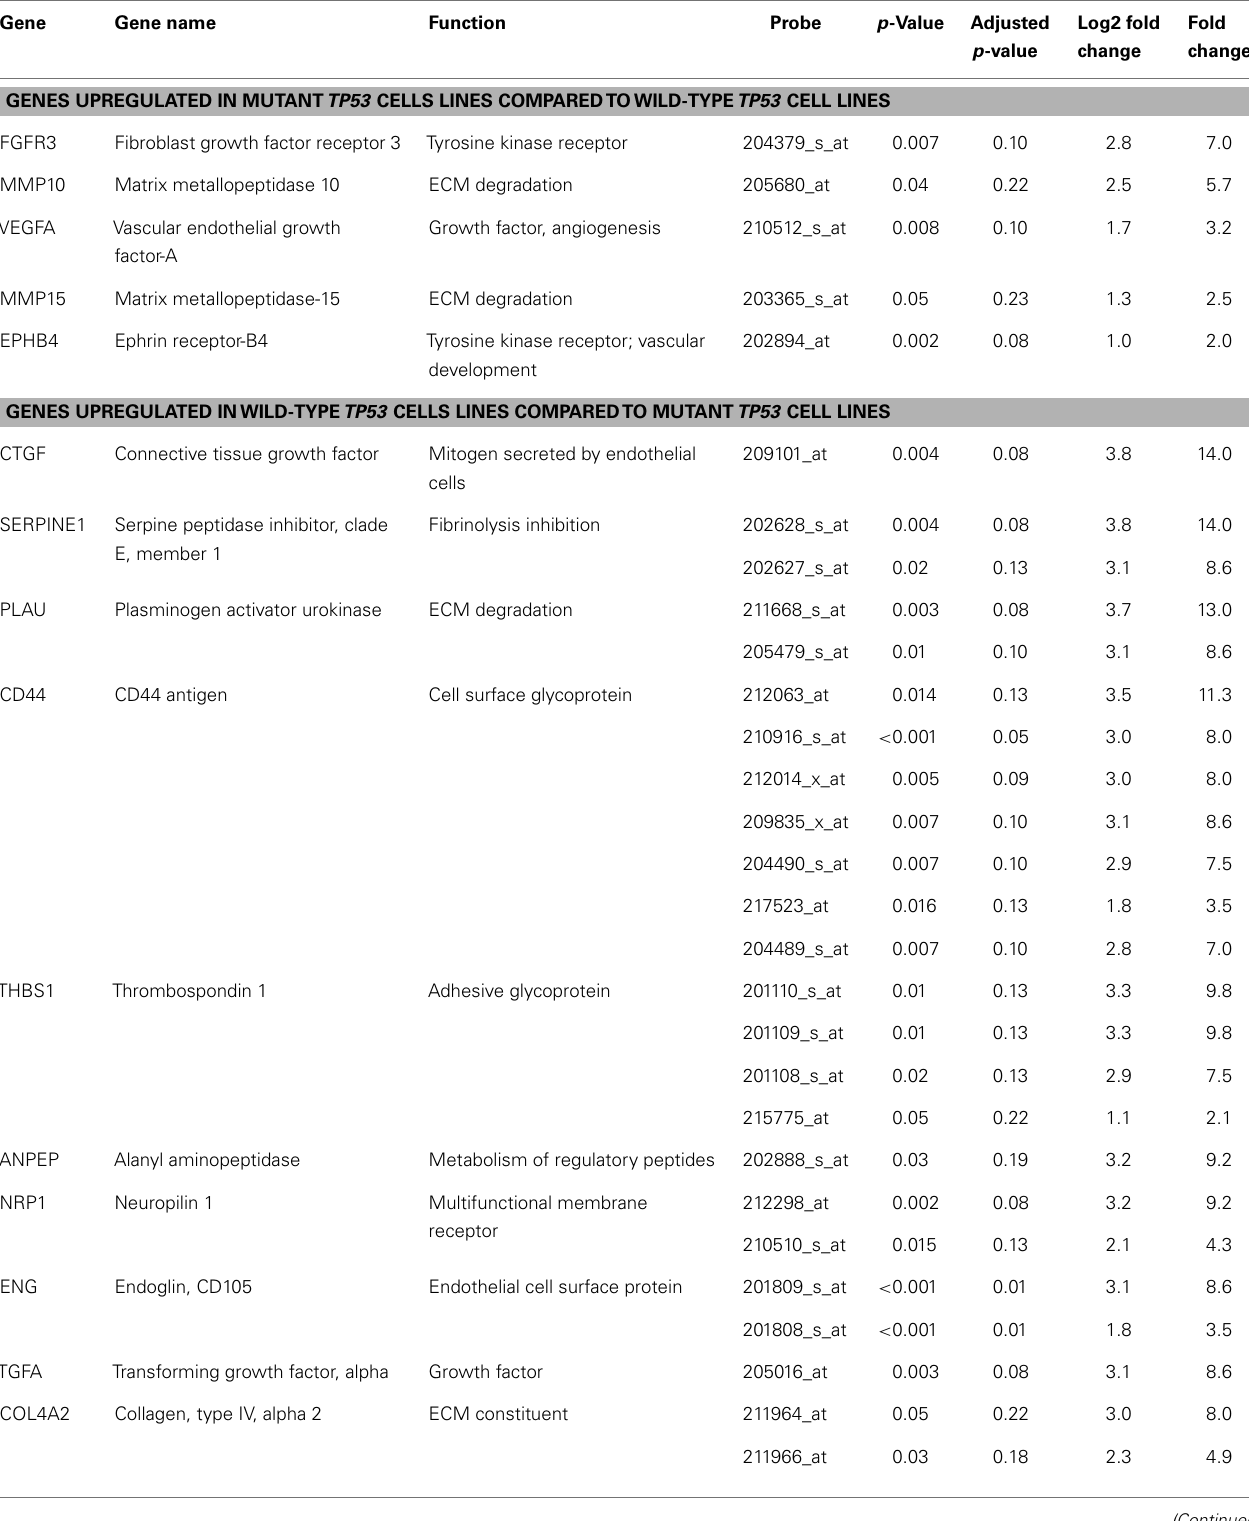
Table 2 |Angiogenic genes that are differentially expressed in ovarian cancer cell lines harboring a mutant TP53 gene compared to those with an intact wild-type TP53 gene